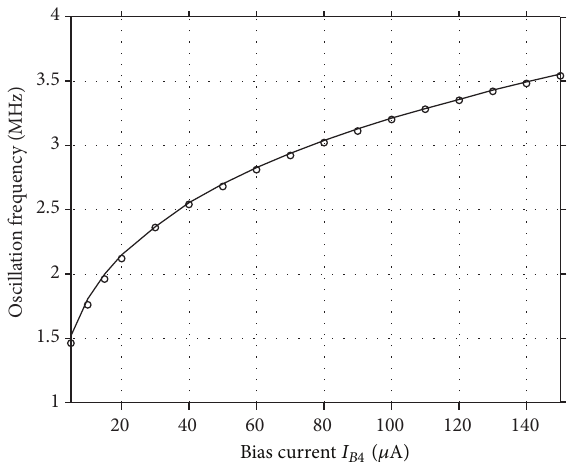
Figure 9: The simulated frequency spectrum of 𝑉 𝑜1 (blue) and 𝑉 𝑜2 (red).